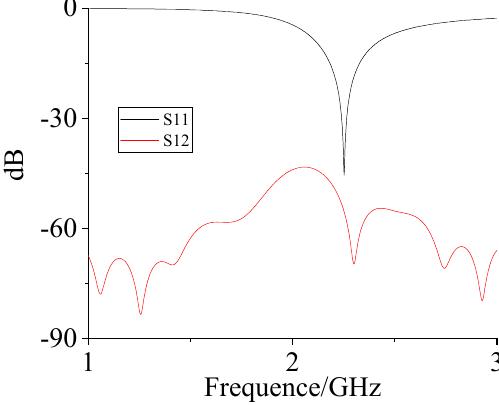
Figure 8. S-parameters of the square array’s element.